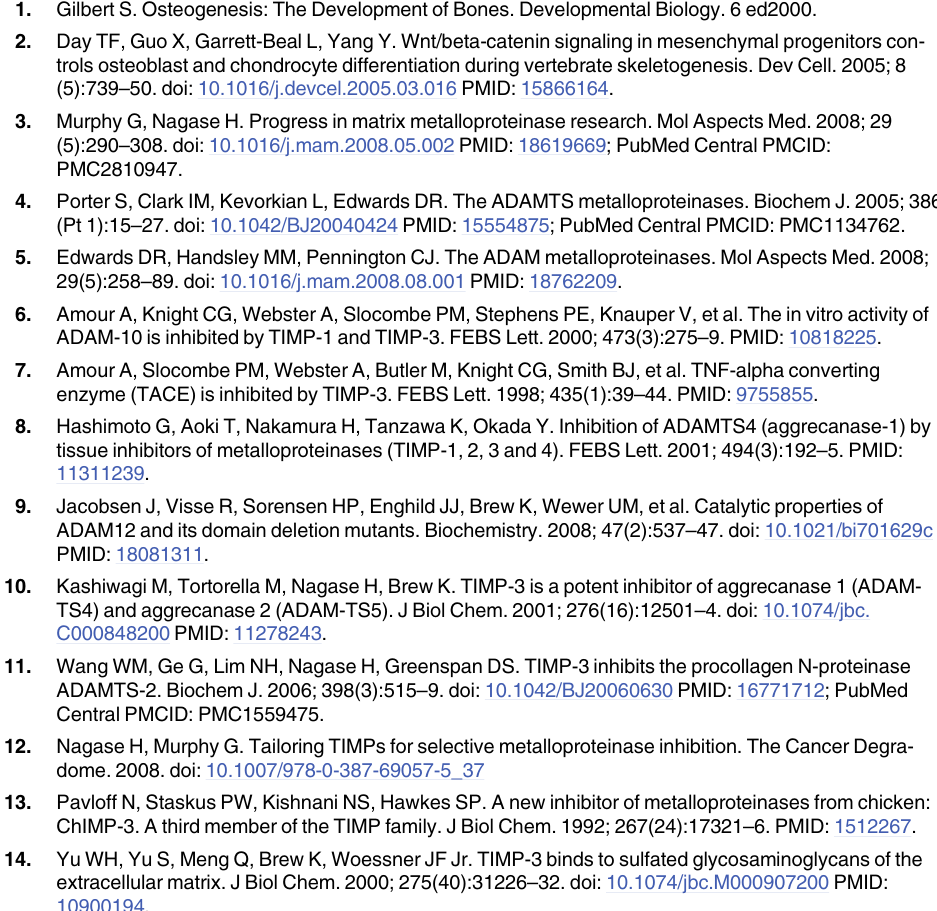
and Timp-3 Tg skull at 8 weeks of F1